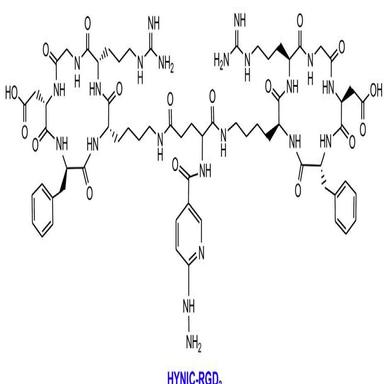
Structure of HYNIC-RGD2 used for formulation 99mTc-labeled radiopharmaceutical targeting integrin αvβ3 receptors.